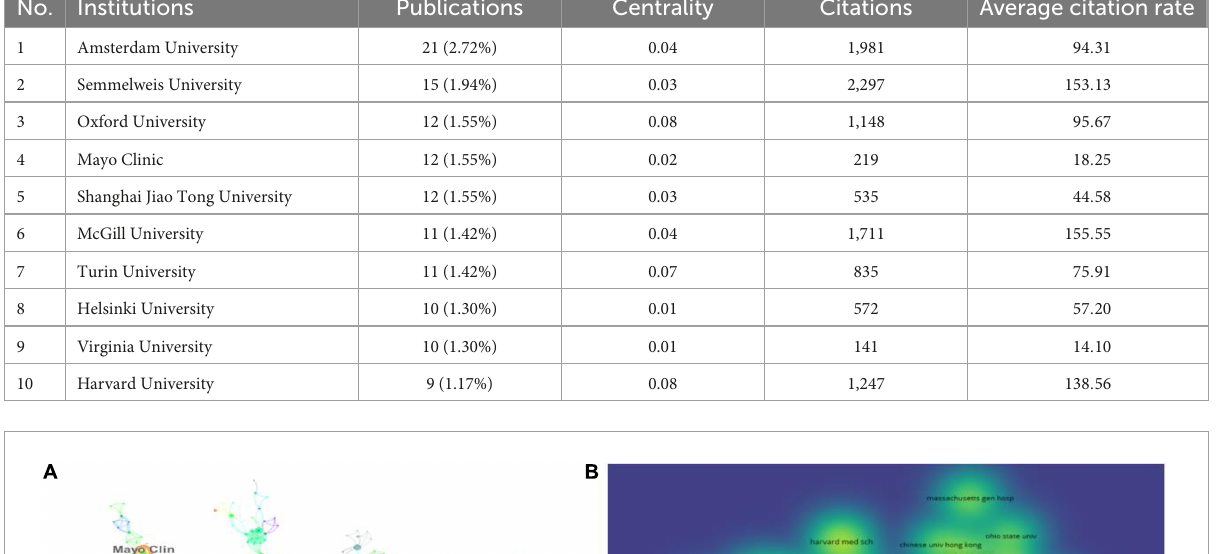
TABLE 3 The top 10 institutions with the most publications in the field of platelet exosomes.